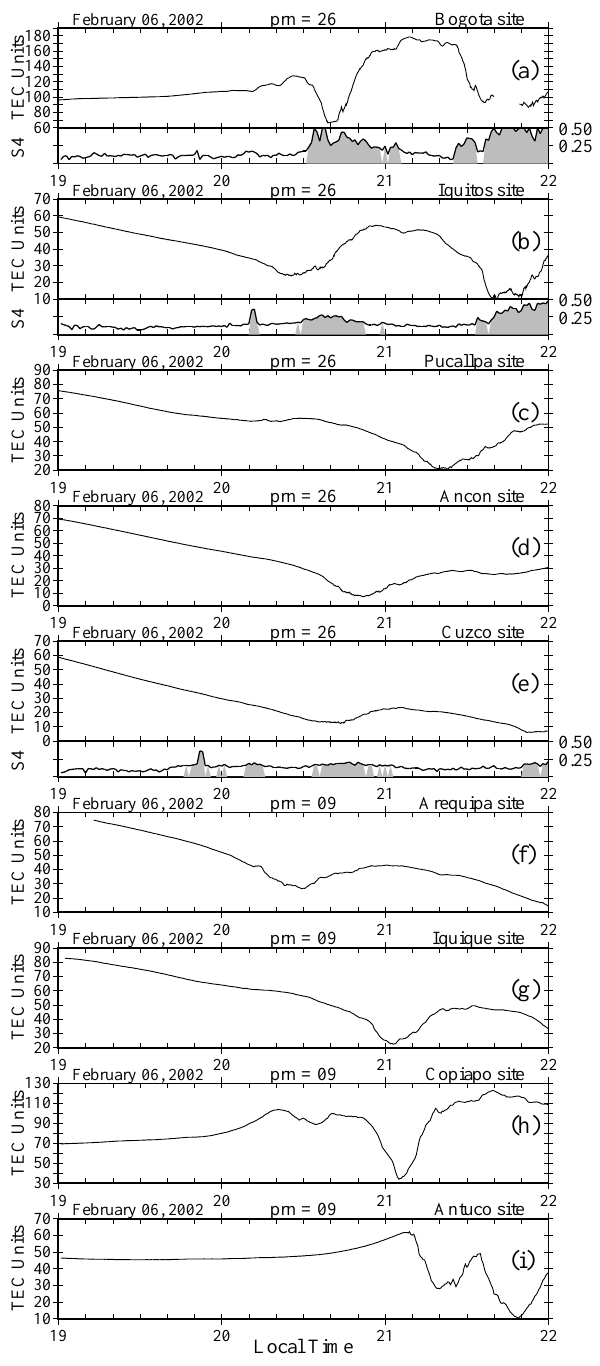
Fig. 3. Same as Fig. 2, but for 6 February 2002. Plasma bubbles drift through the stations fields-of-view at slightly different times. One TEC depletion was seen first at Iquitos at 20:25 LT, then at 20:40 LT at Bogota, and later at Cuzco ∼ 20:45 LT. Ancon and Pu- callpa did not observe the TEC depletion, suggesting that the deple- tion developed in a location between Pucallpa and Iquitos, near the 74 ◦ W meridian and approximately at 20:20